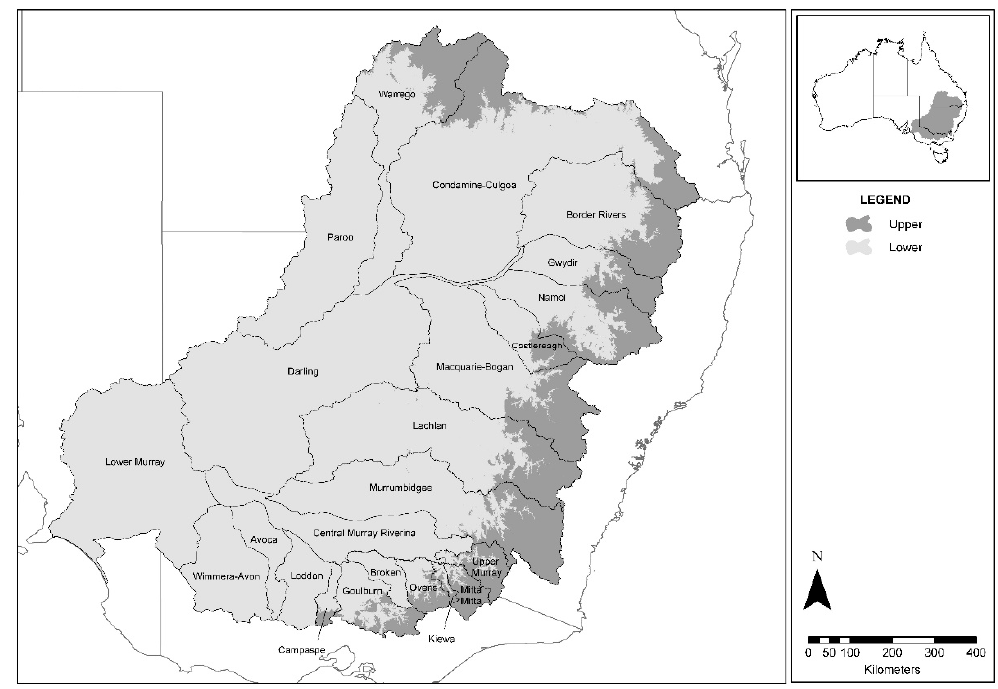
Figure 1. Maximum extent of study area and catchments of the Murray–Darling Basin.